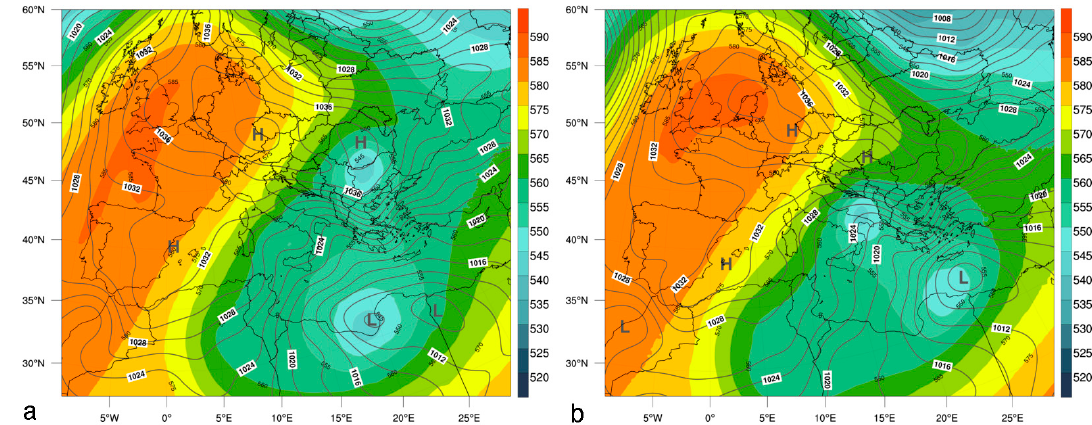
Figure 7. NCEP FNL analysis of 500-hPa geopotential height (shading at 50-gpdm intervals), sea level pressure (grey contours at 2-hPa intervals), valid at ( a ) 0000 UTC 25 February 2019 and ( b ) at 1200 UTC 25 February 2019.